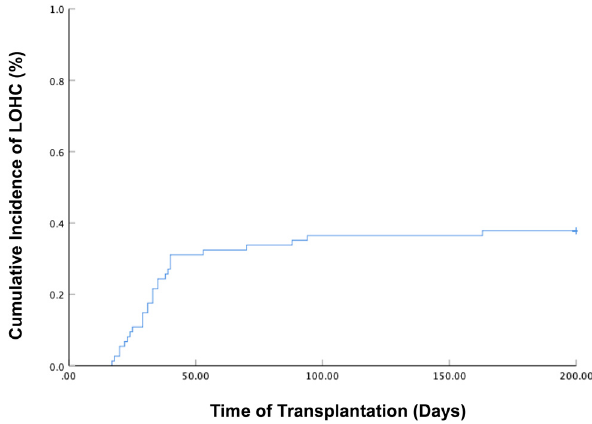
Figure 1: The cumulative incidence of LOHC in the 74 patients after haplo - PBSCT was 37.8% ( 95% CI: 26.9 – 48.7% ) .